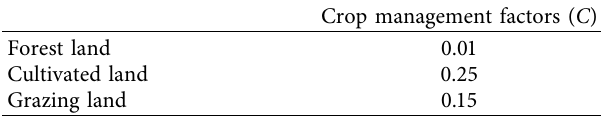
Table 2: Te C Factors (crop management factors).